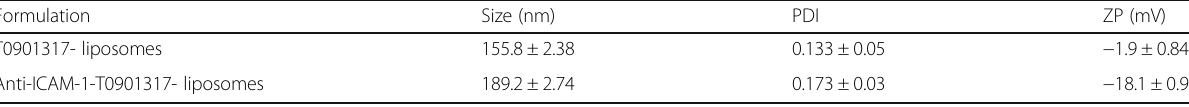
Table 1 Physicochemical characteristics of synthetic NP formulations